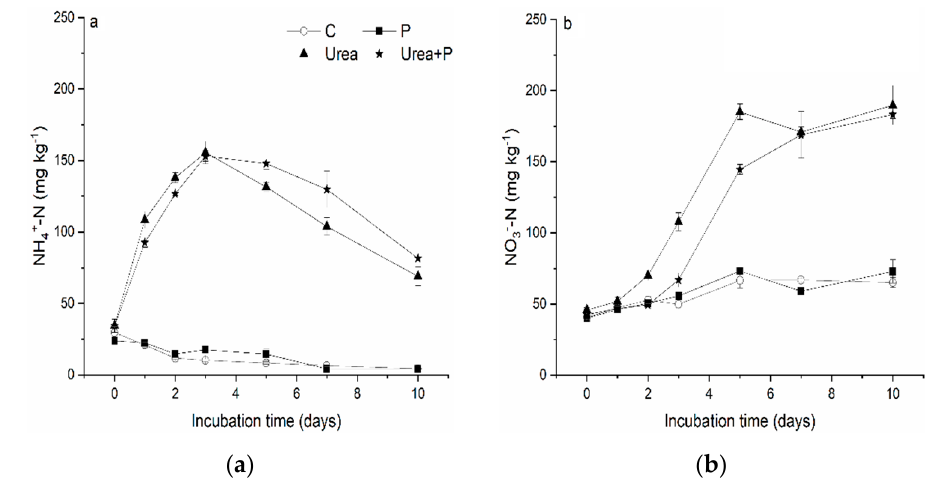
Figure 2. NH 4+ -N ( a ) and NO 3 − -N ( b ) in soil amended with and without urea, P, and urea + P. Legends correspond to the amendment of urea N (urea, 0.20 g N kg − 1 soil), monopotassium phosphate (P, 0.087 g P kg − 1 soil), urea N and monopotassium phosphate (urea + P, 0.20 g N kg − 1 soil + 0.087 g P kg − 1 soil). The soil without N and P addition was used as the control (C, control). Three soil samples in each treatment were taken after 0, 1, 2, 3, 5, 7 and 10 days of incubation. Data in the figure represent means ± standard deviations ( n = 3).